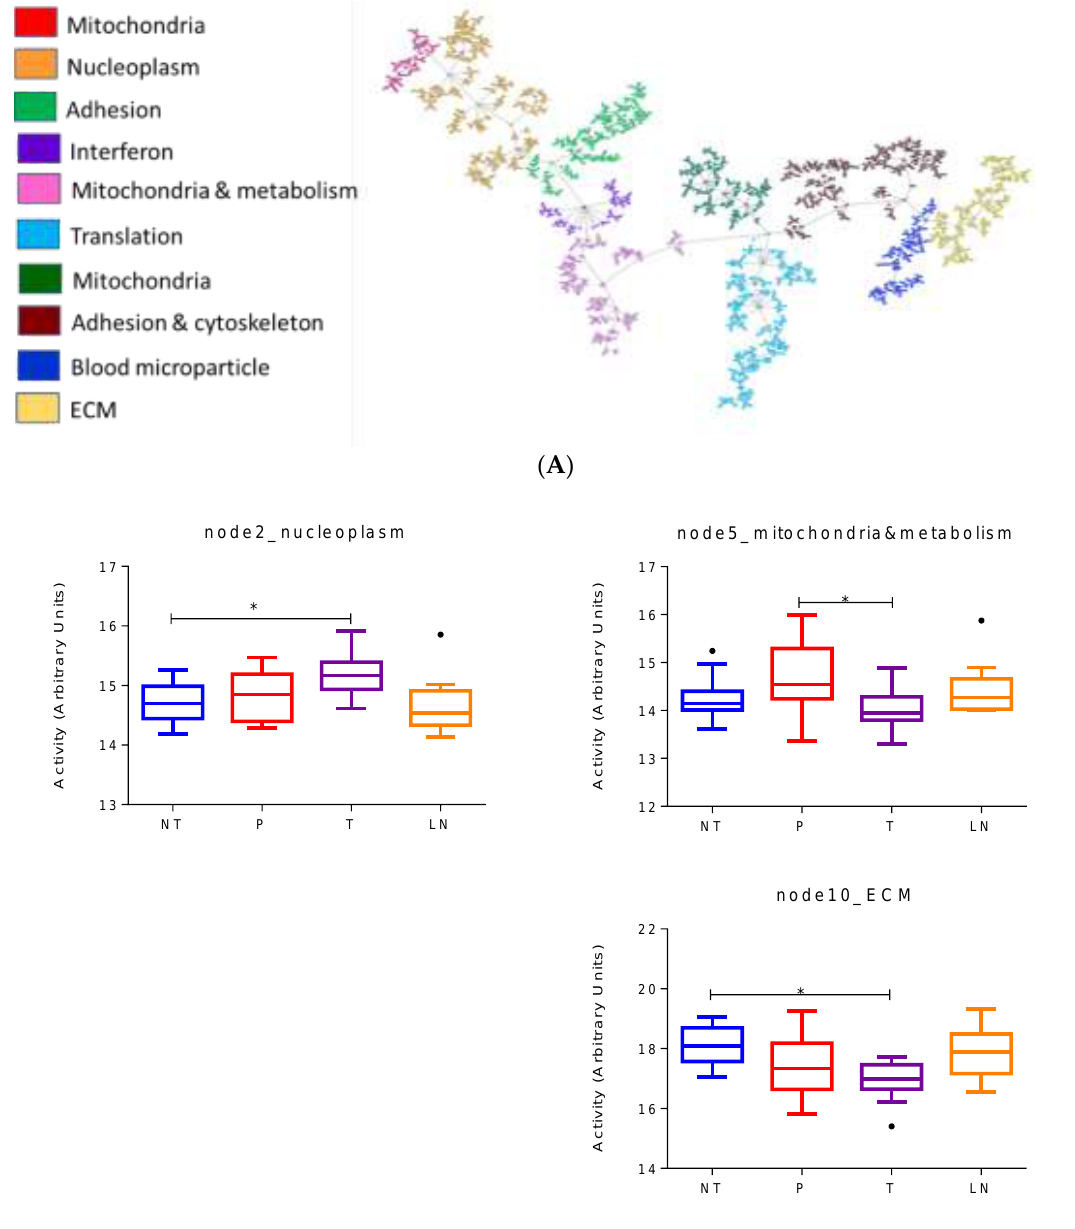
Figure 5. ( A ) Network of 2311 proteins in the T3 subtype. ( B ) Differential functional node activities comparing the different histological samples in the T3 subtype according to mixed lineal models. NT = normal tissue, P = preneoplastic lesions, T = primary tumors, LN = lymph nodes. * p < 0.05.